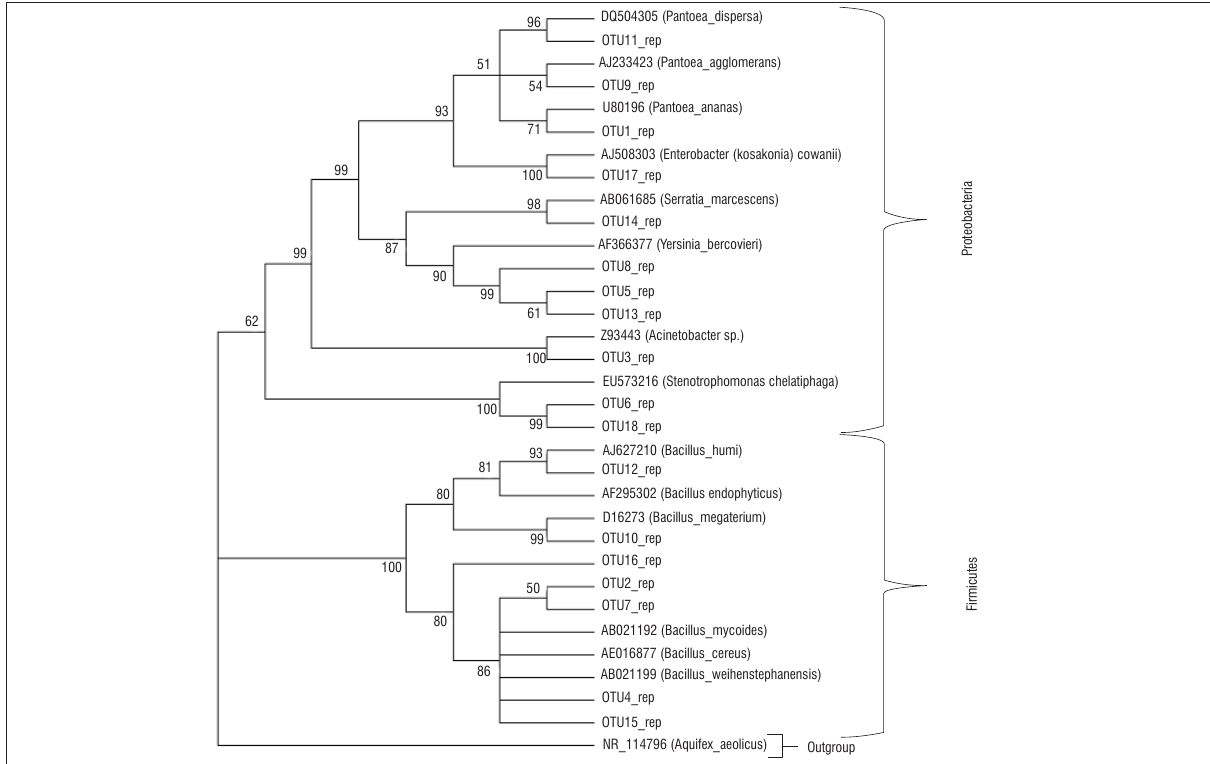
Figure 4: Phylogenetic relationship of representative operational taxonomic units (OTUs) of 90-day-old Bt and non-Bt bacterial isolates based on 16S rDNA gene and closely related sequences (Jukes–Cantor algorithm and neighbour-joining tree). Bootstrap values are based on 1000 replicates and are indicated in branches; Aquifex aeolicus was used as an